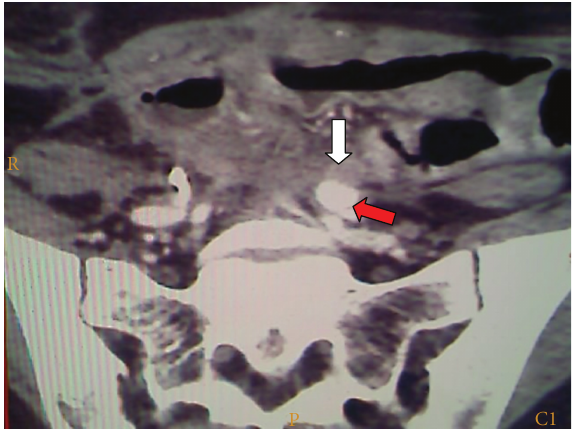
Figure 3: CT scan demonstrating left common iliac artery (red arrow) and left ureter (white arrow) which appear not